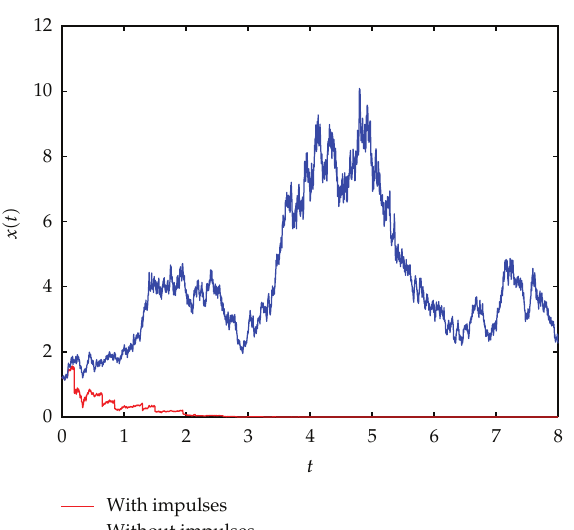
Figure 4: Impulsive control of Example